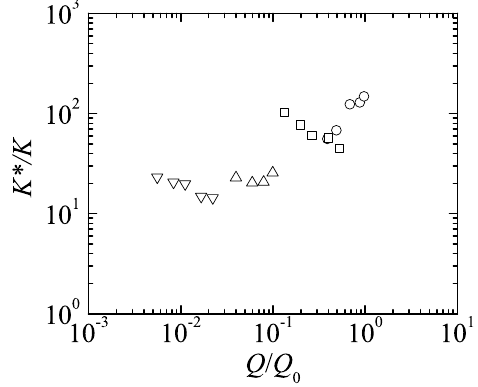
Fig. 6. Current intensity I = I 0 as a function of the flow rate Q = Q ∗ The open and solid symbols correspond to the needle and cap- illary configurations, respectively. The solid line is the function (1).